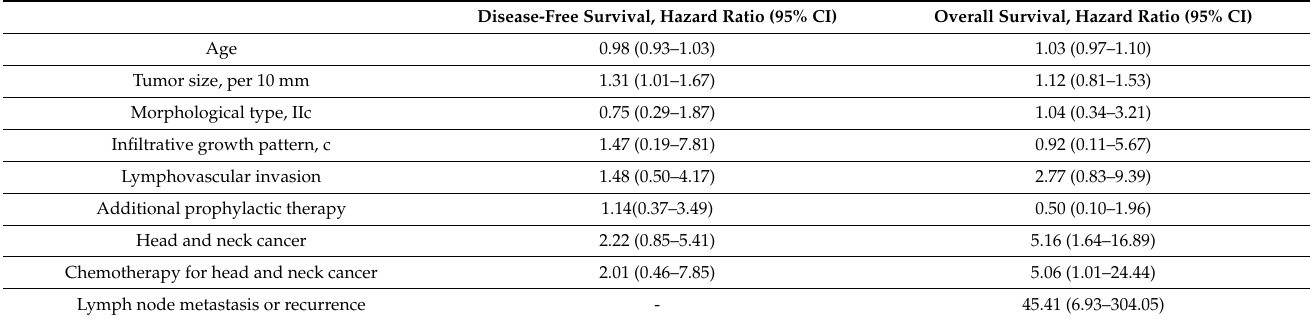
Table 4. Factors associated with disease-free survival and overall